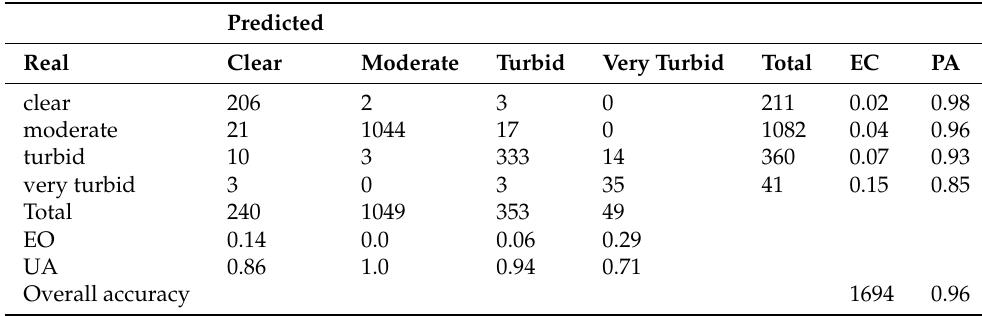
Table 2. Confusion matrix of RFC with all bands. EC is error of commission; EO is error of omission; PA is the producer’s accuracy; UA is the user’s